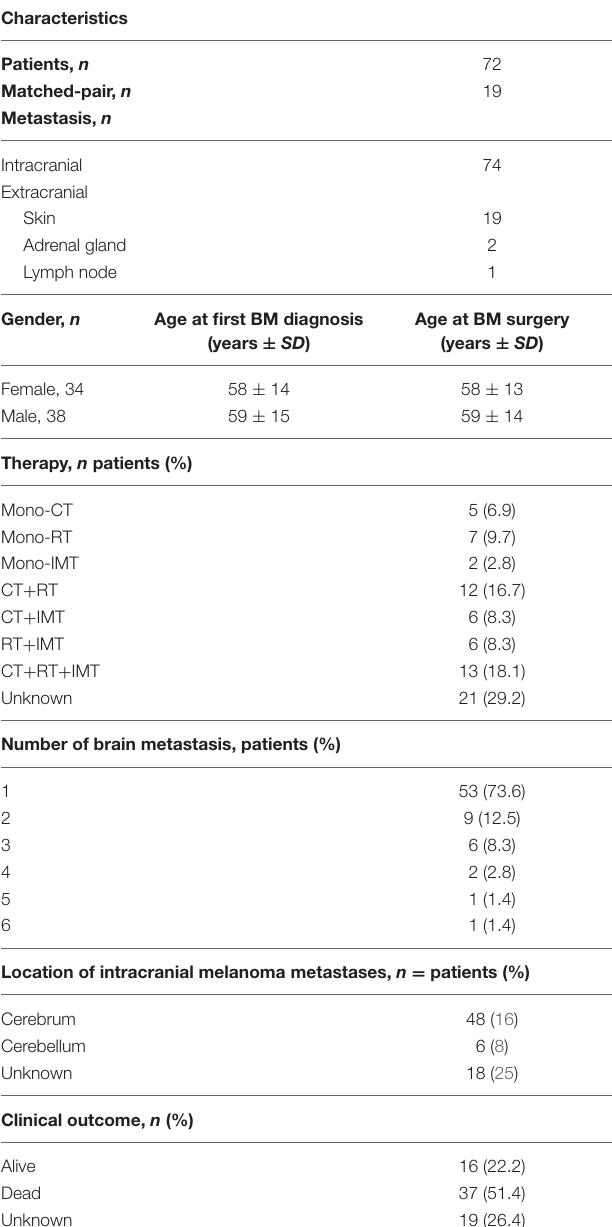
TABLE 1 | Patients characteristics and clinical